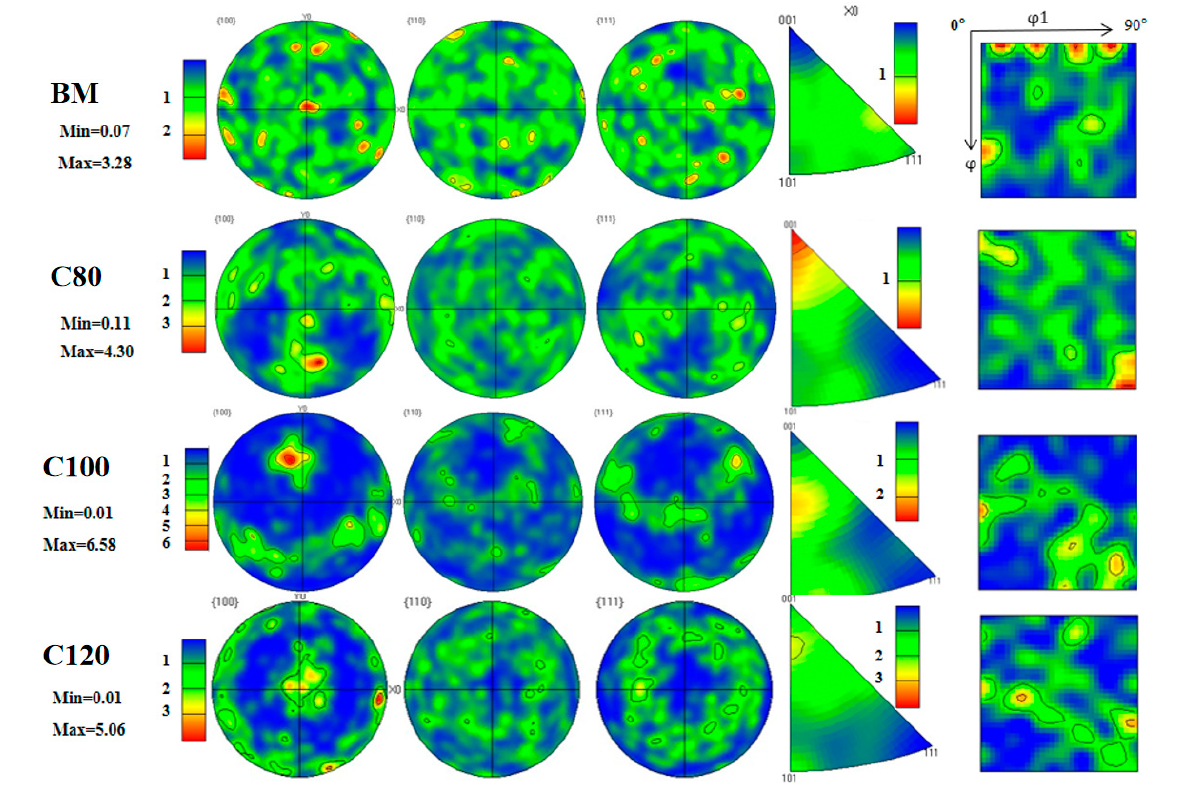
Figure 5. Corresponding pole image, reverse pole image, and ODF image of each area of the sample after 80 mm/min to 120 mm/min electron beam scanning ( φ 2 = 45°).